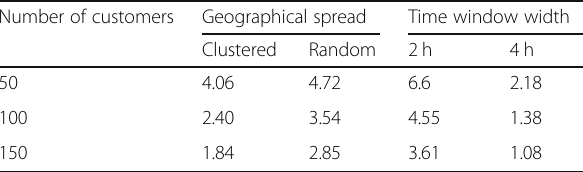
Table 5 Average increase in cost per customer for selecting a delivery time window (1)